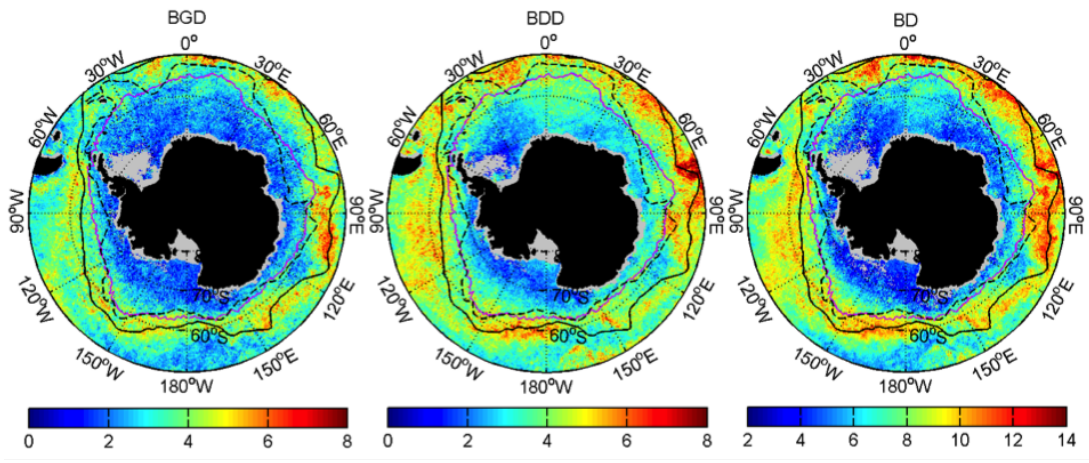
Figure 4. Same as Figure 3, but for bloom growth duration (BGD), bloom decline duration (BDD) and total duration (BD) of the diatom blooms. Units are in